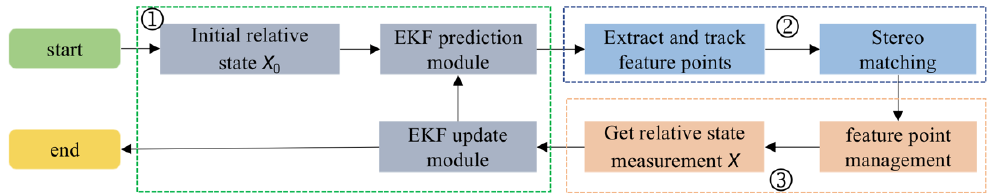
Figure 2. The overall algorithm design scheme for relative pose measurement. The state dynamic equation is regarded as the filter motion equation. First, the predicted pose results are obtained by the EKF prediction module, using the relative orbit dynamics and the relative attitude dynamics model. Then, the target feature points in the binocular camera image are extracted by using the Features from Accelerated Segment Test (FAST) algorithm, and the 3D position of the points is calculated according to the convergent binocular stereo vision measurement. More representative feature points can be acquired and tracked between frames by using the optical flow method. A stereo-matching approach is used to obtain the geometric constraint information between the frames. The relative attitude and angular velocity are first calculated from the tracked feature points, and then position and velocity. Finally, the measurement results are optimized through the EKF update module to obtain final results with less